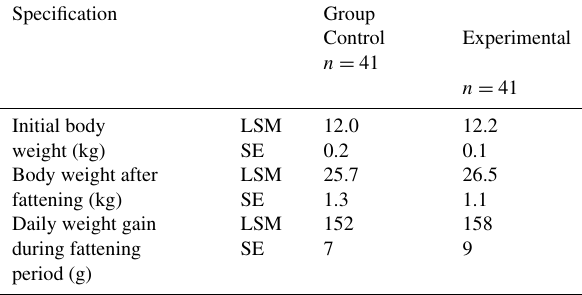
Table 2. The body weights and daily gains of the goat kids. Table 3. Percentage of primal cuts, kidneys and perirenal fat ob- tained from the carcasses (%).